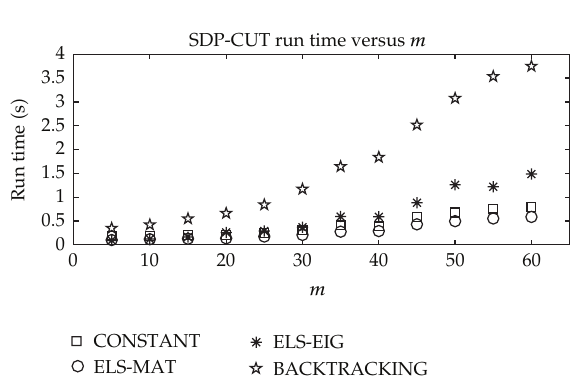
Figure 12: SDP-CUT time as it varies with matrix size.